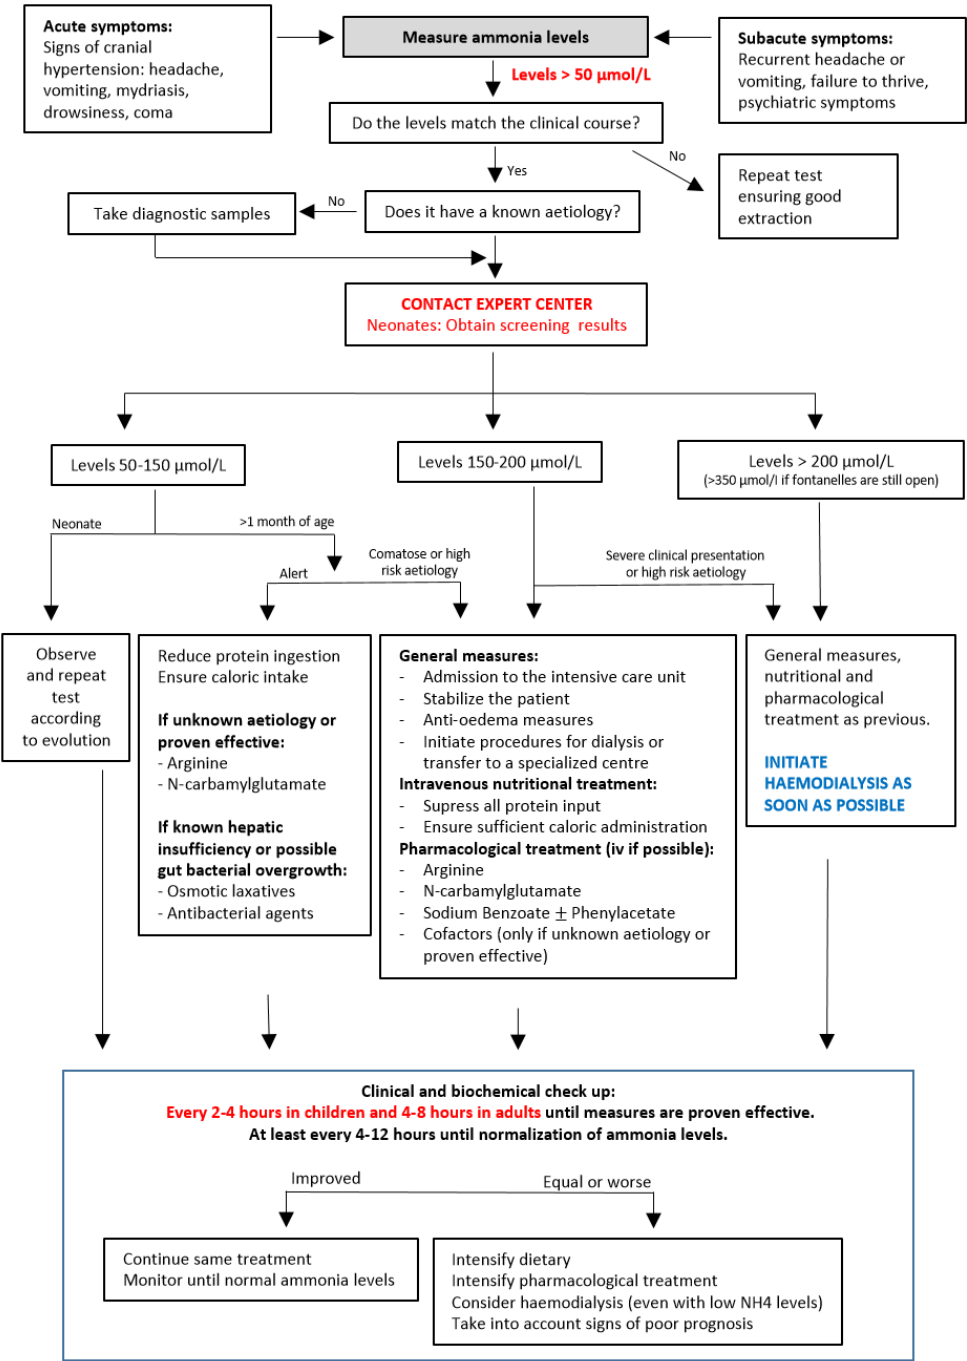
Figure 1. Treatment algorithm for hyperammonaemia (if unknown diagnosis or useful for eathiol-